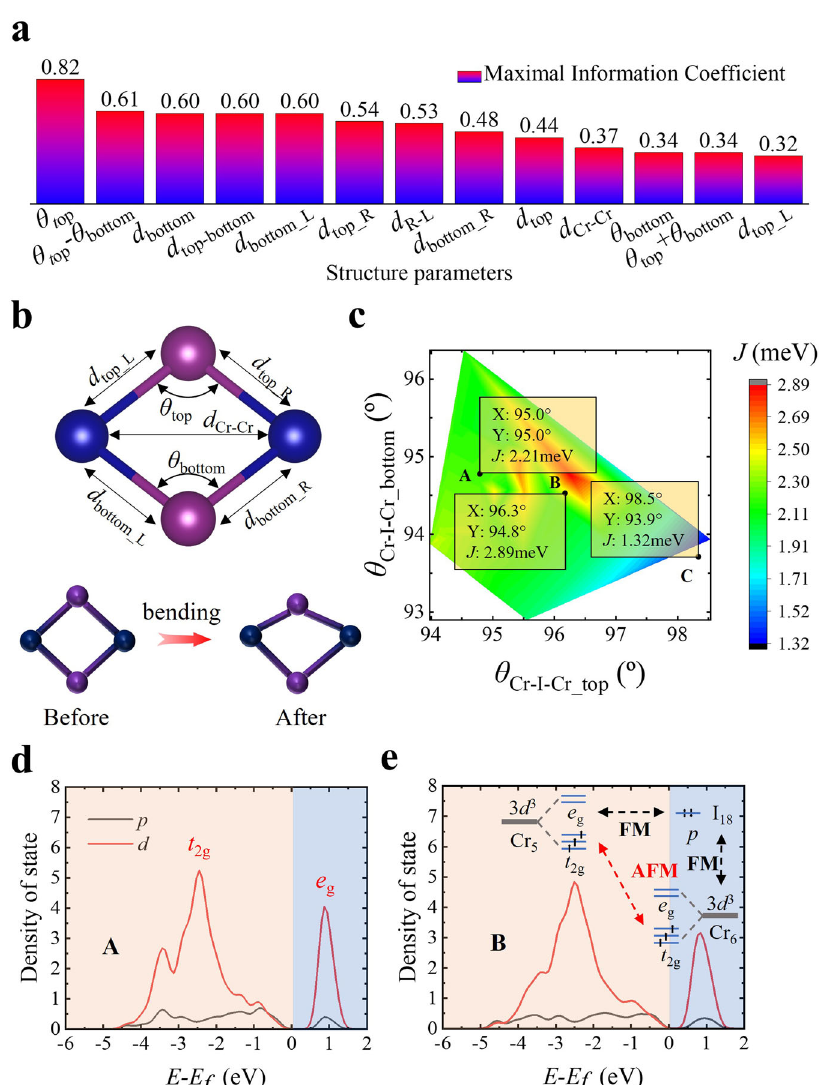
Fig. 3 Variation of exchange interaction with distorted bonds under bending. a MICs between the exchange interaction J and the structural parameters of each Cr-Cr pair, d top = d top_L + d top_R , d bottom = d bottom_L + d bottom_R and d R-L = d top_R + d bottom_R − d top_L − d bottom_L . b Sketch of a bending deformation of a Cr-Cr pair with all the structural parameters listed in a . c Contour plot for exchange interaction as the function of Cr-I-Cr angles. The PDOSs of d the Cr 7 -I 24 -Cr 8 pair in the B0 nanoribbon and e the Cr 5 -I 18 -Cr 6 pair in the B250 nanoribbon corresponds to points A and B in c , respectively. The inset in e is the sketch of the FM superexchange interaction through t 2g - p - e g orbitals and the AFM direct exchange between two Cr half-occupied t 2g